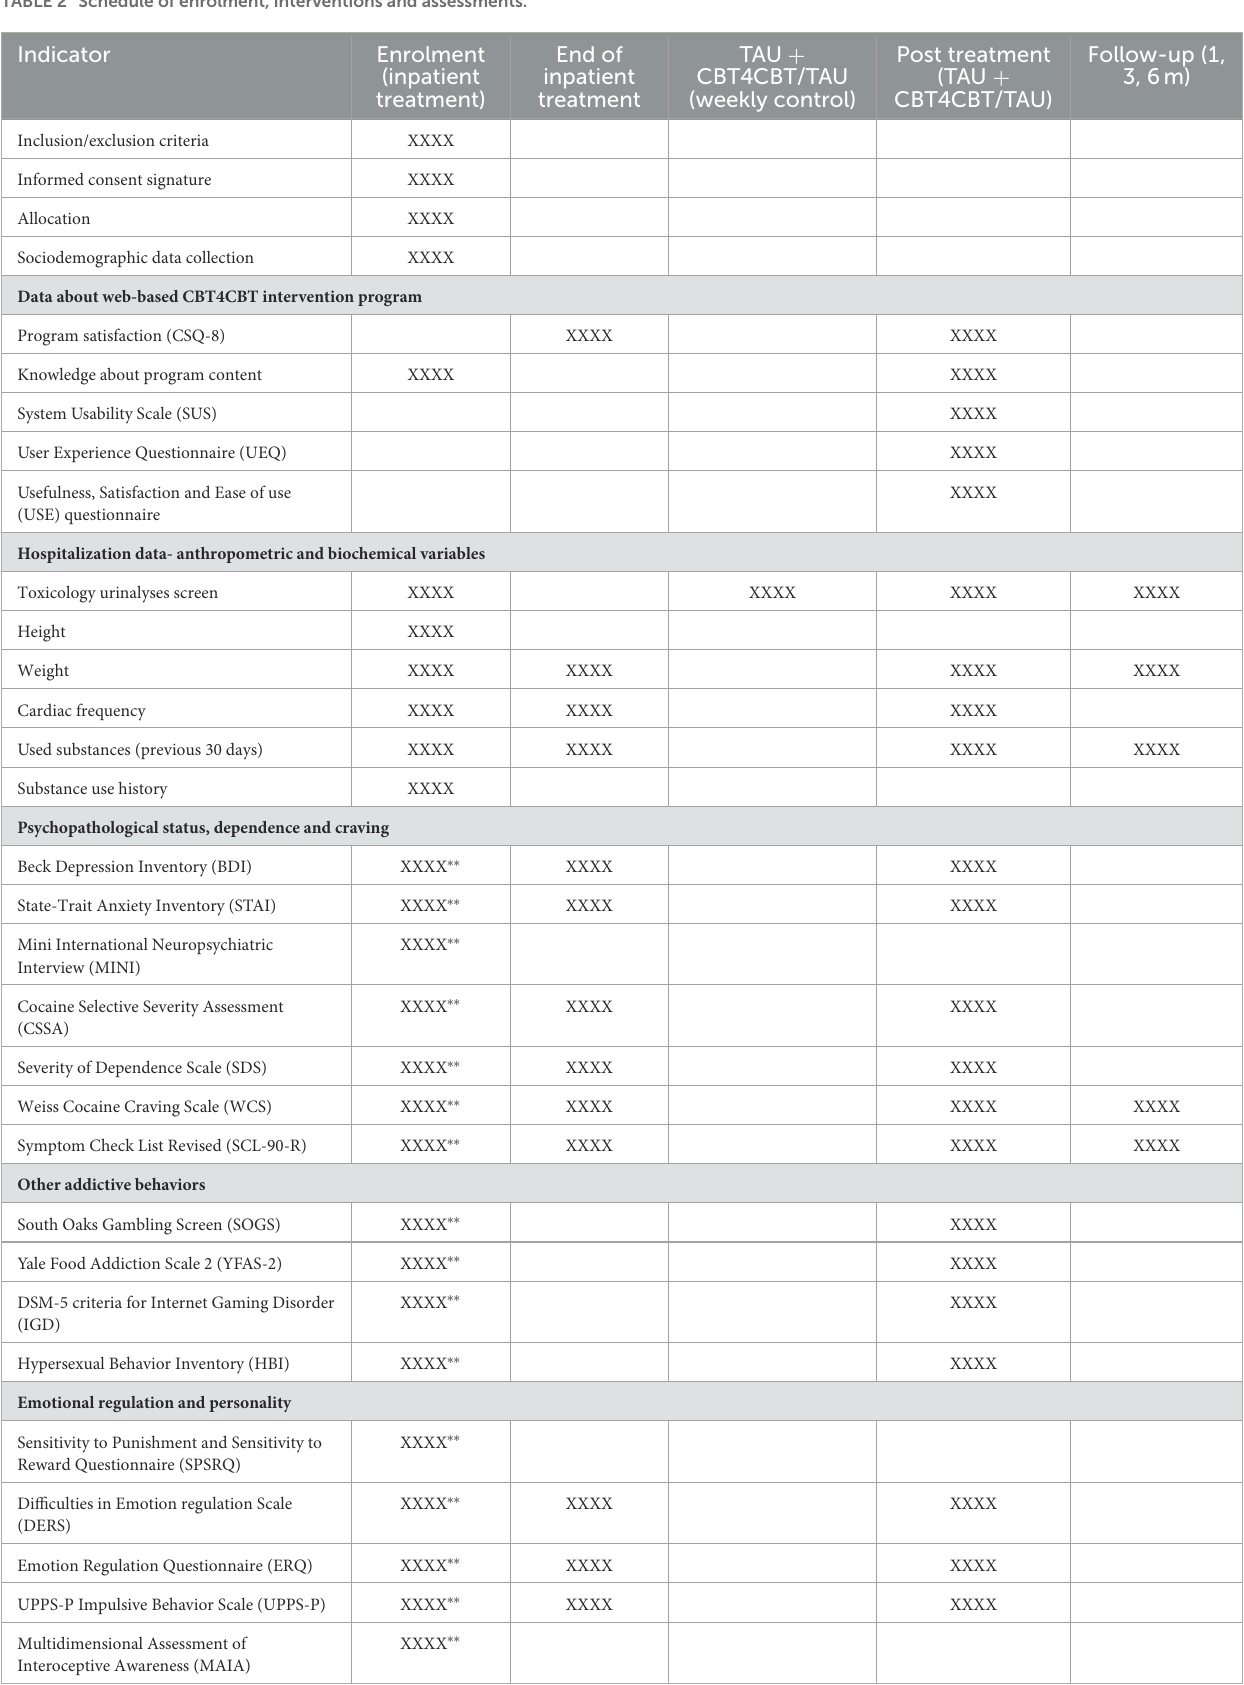
TABLE 2 Schedule of enrolment, interventions and assessments. Indicator Enrolment